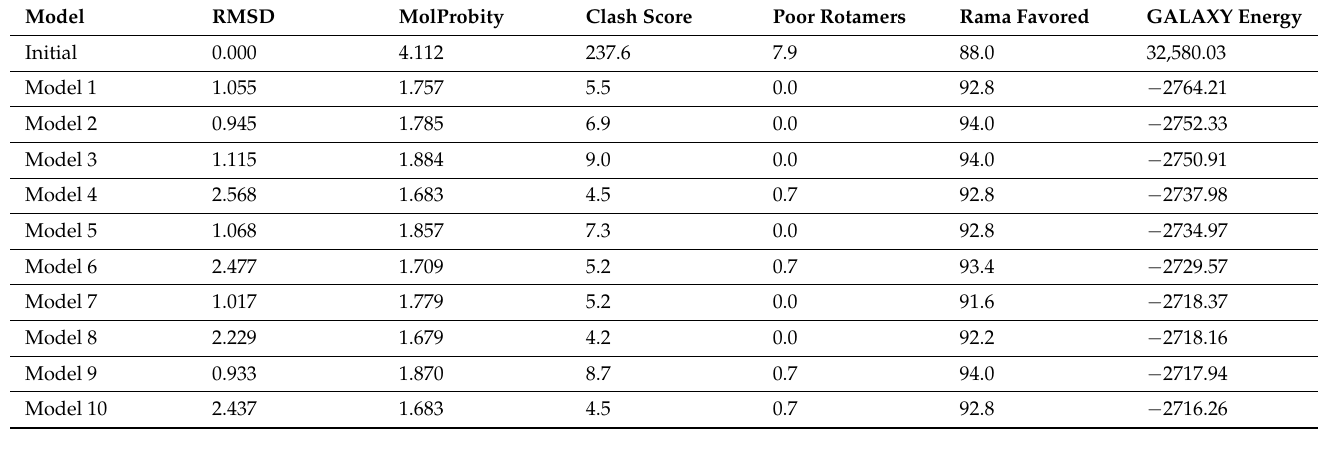
Table 2. Structural features of top 10 models generated after refining multi-epitope vaccine structure.